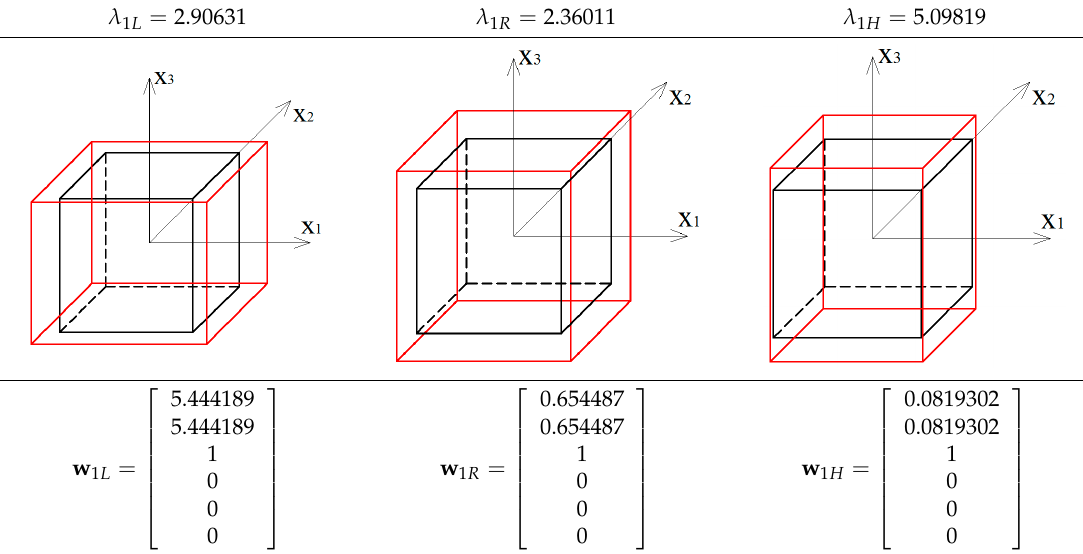
Table 2. Soft (extensional) mode of deformation.